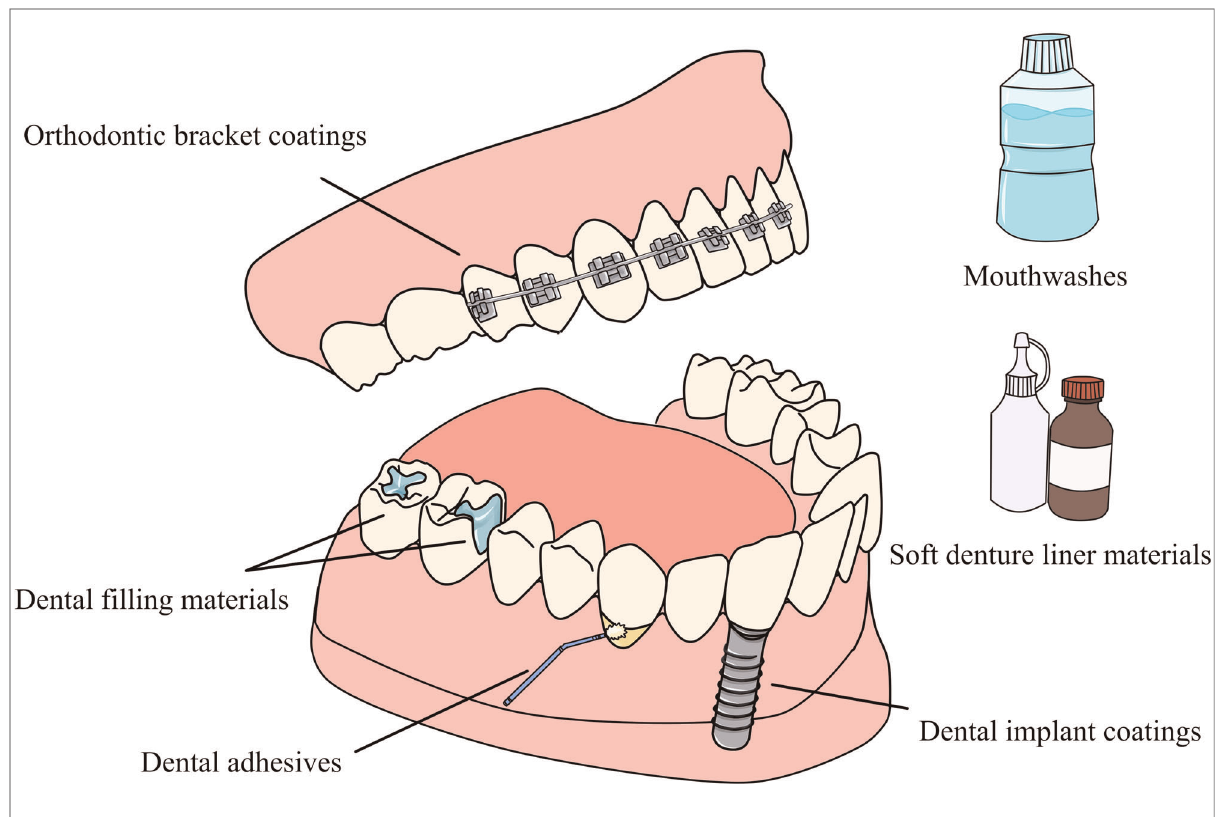
FIGURE 6 Application of copper-containing NPs in